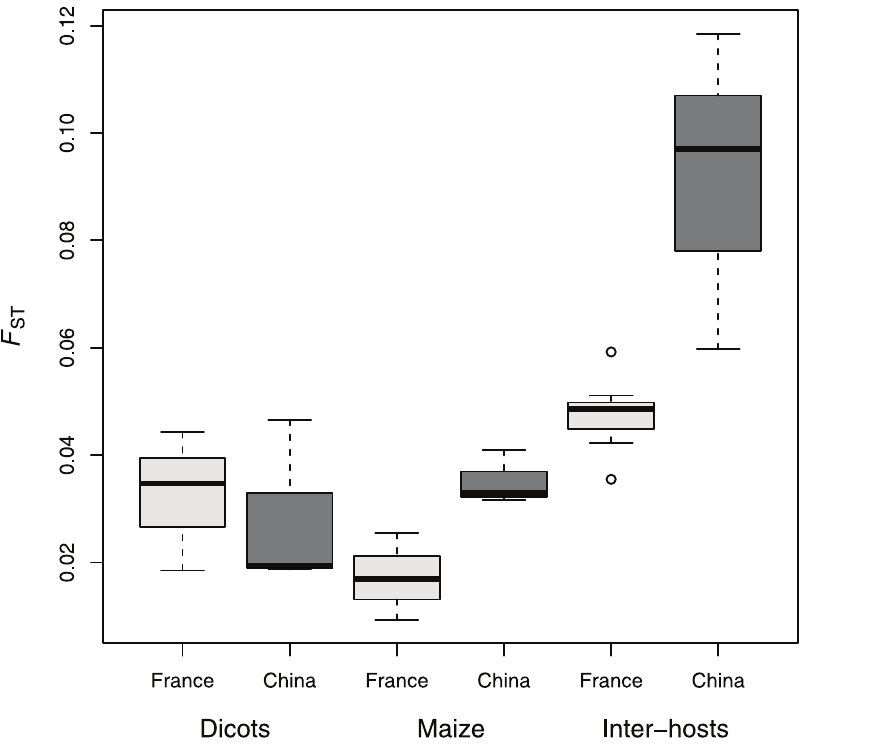
Figure 2. Boxplot of multi-locus F ST estimates for pairwise intra- and inter-host comparisons among French (light grey) and Chinese (dark grey) populations.